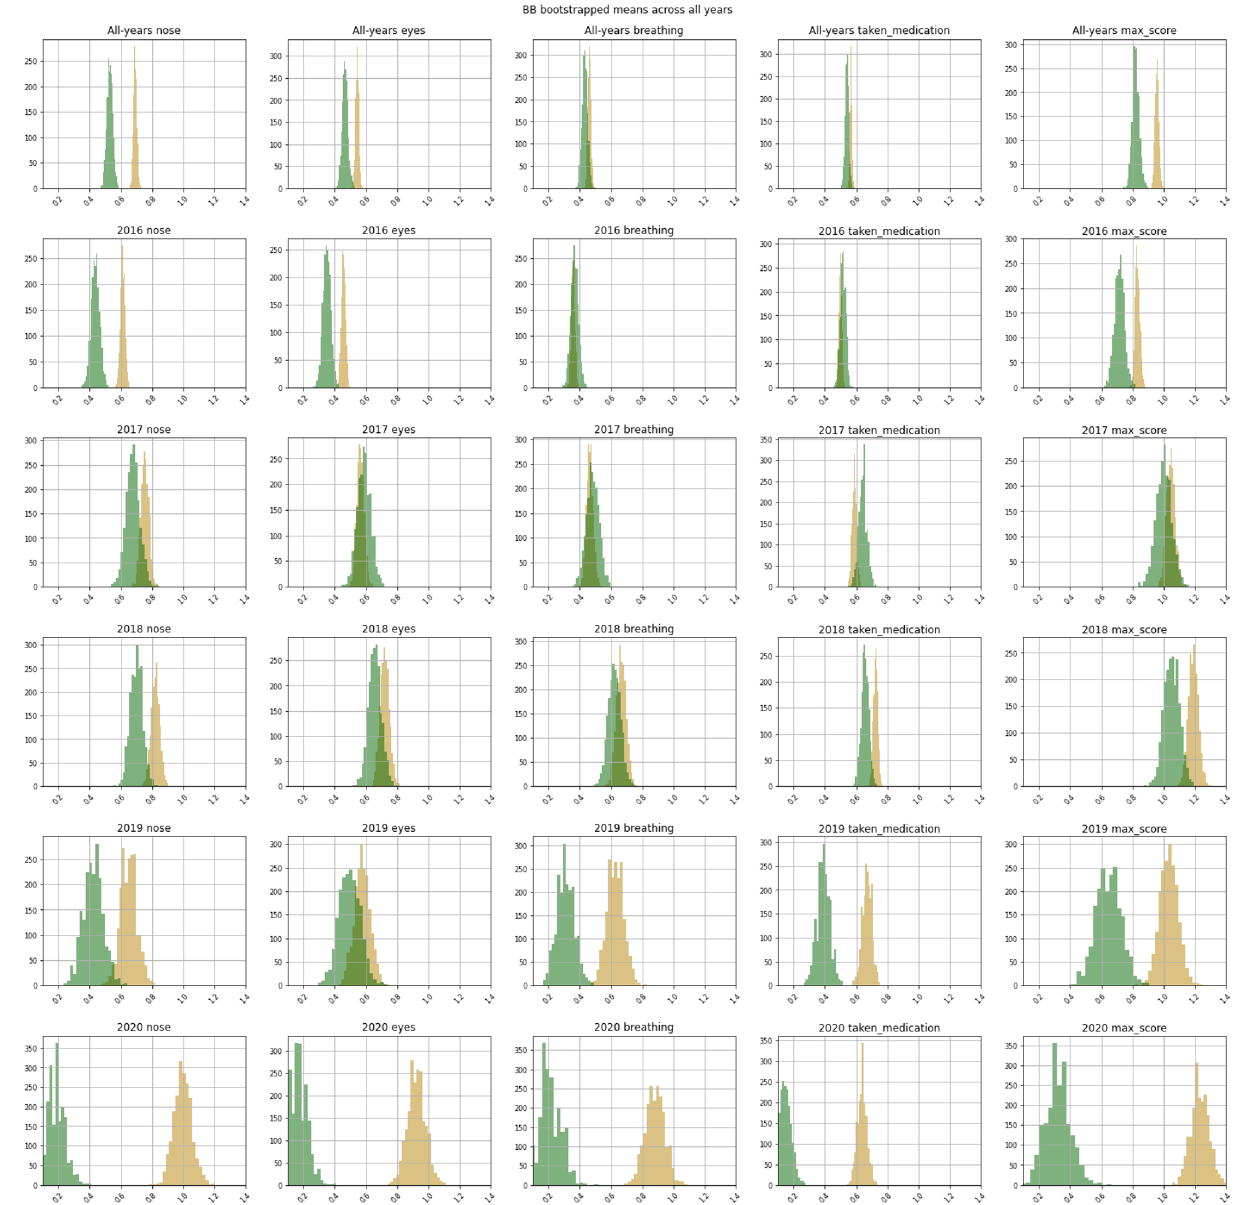
Figure 2. Urban (gold) vs rural (green) bootstrap re-sampling of average symptom severity. Each column presents a single symptom (left to right: nose, eyes, breathing, taken medication and max score). Each row contains a different year (top to bottom: all years, 2016, 2017, 2018, 2019 and 2020). Y-axes represent counts, x-axes represent mean scores. Each sample size is 20% of original data, and 2000 different samples were used for this